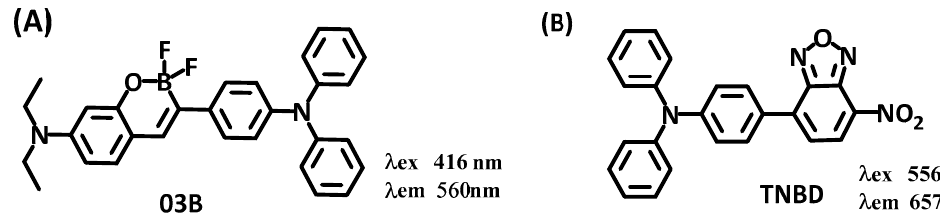
Figure 7. Structures and Emission ( λ ex )/excitation ( λ em ) performance of lipid droplet probes 03B and TNBD.